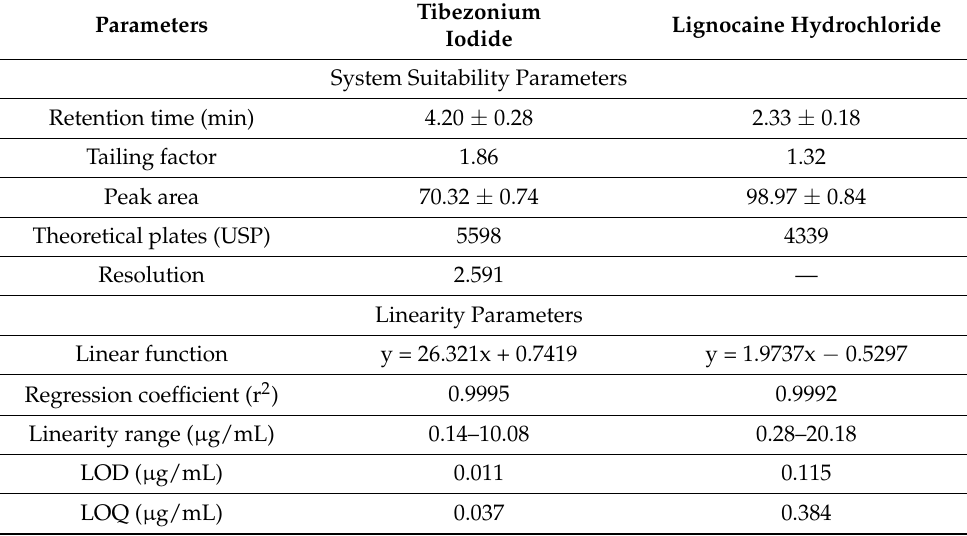
Table 1. System suitability, linearity, LOD and LOQ of the devised method for simultaneous detection of TBN and